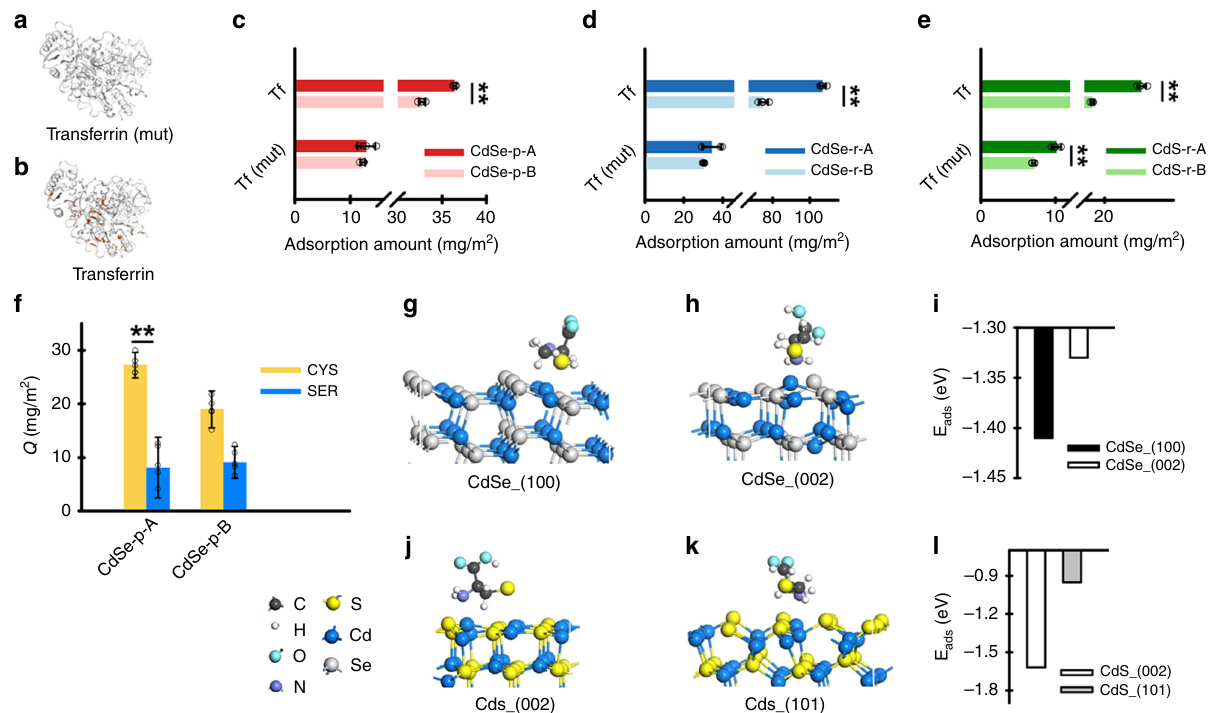
Fig. 4 Facet-dependent preferential binding of transferrin with Cd nanocrystals occurred through thiol complexation. a , b Schematic description of the structures of transferrin and non-thiol transferrin (mut) (cysteine shown in red). Adsorption of transferrin on CdSe nanoparticles ( c , CdSe-p-A: dark red bar; CdSe-p-B: light red bar; p = 0.0006 for transferrin and 0.4071 for transferrin (mut)), CdSe nanorods ( d , CdSe-r-A: dark blue bar; CdSe-r-B: light blue bar; p < 0.0001 for transferrin and = 0.1306 for transferrin (mut)) and CdS nanorods ( e , CdS-r-A: dark green bar; CdS-r-B: light green bar; p = 0.0003 for transferrin and 0.0006 for transferrin (mut)) was consistently greater compared with the non-thiol transferrin (mut). Data are presented as mean ± SD of four replicate samples, and analyzed by one-way ANOVA ( n = 4). Competitive adsorption of cysteine (CYS) vs. serine (SER) ( f , CYS: yellow bar; SER: blue bar) on the two different-faceted CdSe nanoparticles showed that thiol-containing compounds preferentially adsorbed to the “ A ” material. Data are presented as mean ± SD of fi ve replicate samples ( n = 5; p = 0.0098 for cysteine and 0.8567 for serine by one-way ANOVA). Density function theory (DFT) calculation indicated that cysteine exhibited lower adsorption energy toward (100) vs. (002) of CdSe ( g – i , CdSe_(100): black bar; CdSe_(002): white bar), and exhibited lower adsorption energy toward (002) vs. (101) of CdS ( j – l , CdS_(002): white bar; CdS_(101): gray bar). Statistical signi fi cance between groups: ** p < 0.01. Source data are provided as a Source Data fi (Fig. 5f, g). The facet-dependent differential af fi nity to water was corroborated by the adsorption energy values of water molecules on the CdSe-(100) facet ( − 0.33 eV) vs. CdSe-(002) facet ( − 0.66 eV) according to the DFT calculation. Due to the relatively low af fi nity of the (100) facet to water, the hydrogen bonds in the FSS on this facet dominantly formed among water molecules (Fig. 5h). In the FSS on the (002) facet, although the overall abundance of hydrogen bonds was smaller than the (100) facet (Fig. 5i, j), a good fraction of hydrogen bonds formed between water molecules and the (002) facet. As a result, the interfacial water was more tightly bound to the (002) facet than to the (100) facet, which rendered it dif fi cult for transferrin to replace these water molecules prior to forming inner-sphere coordination bonds with the (002) facet. Hence, a less compact and loosely bound water molecule network occurred on the (100) facet and facilitated the approaching process of transferrin toward the facet from bulk solution, which may, at least partly, explain the preferential binding of transferrin to CdSe nanocrystals with larger (100) content (Figs. 2 and 4c – e).